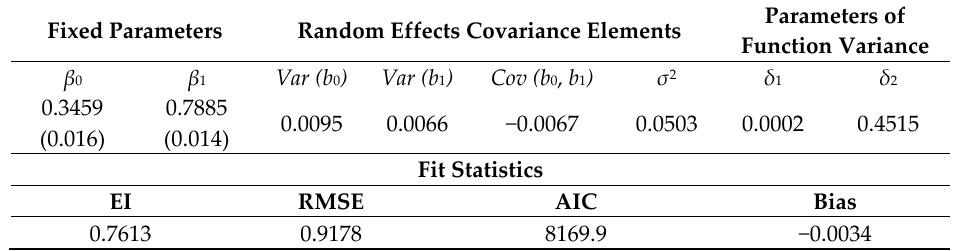
Table 5. Estimated parameters and fitting statistics of the simple mixed model (MM2).